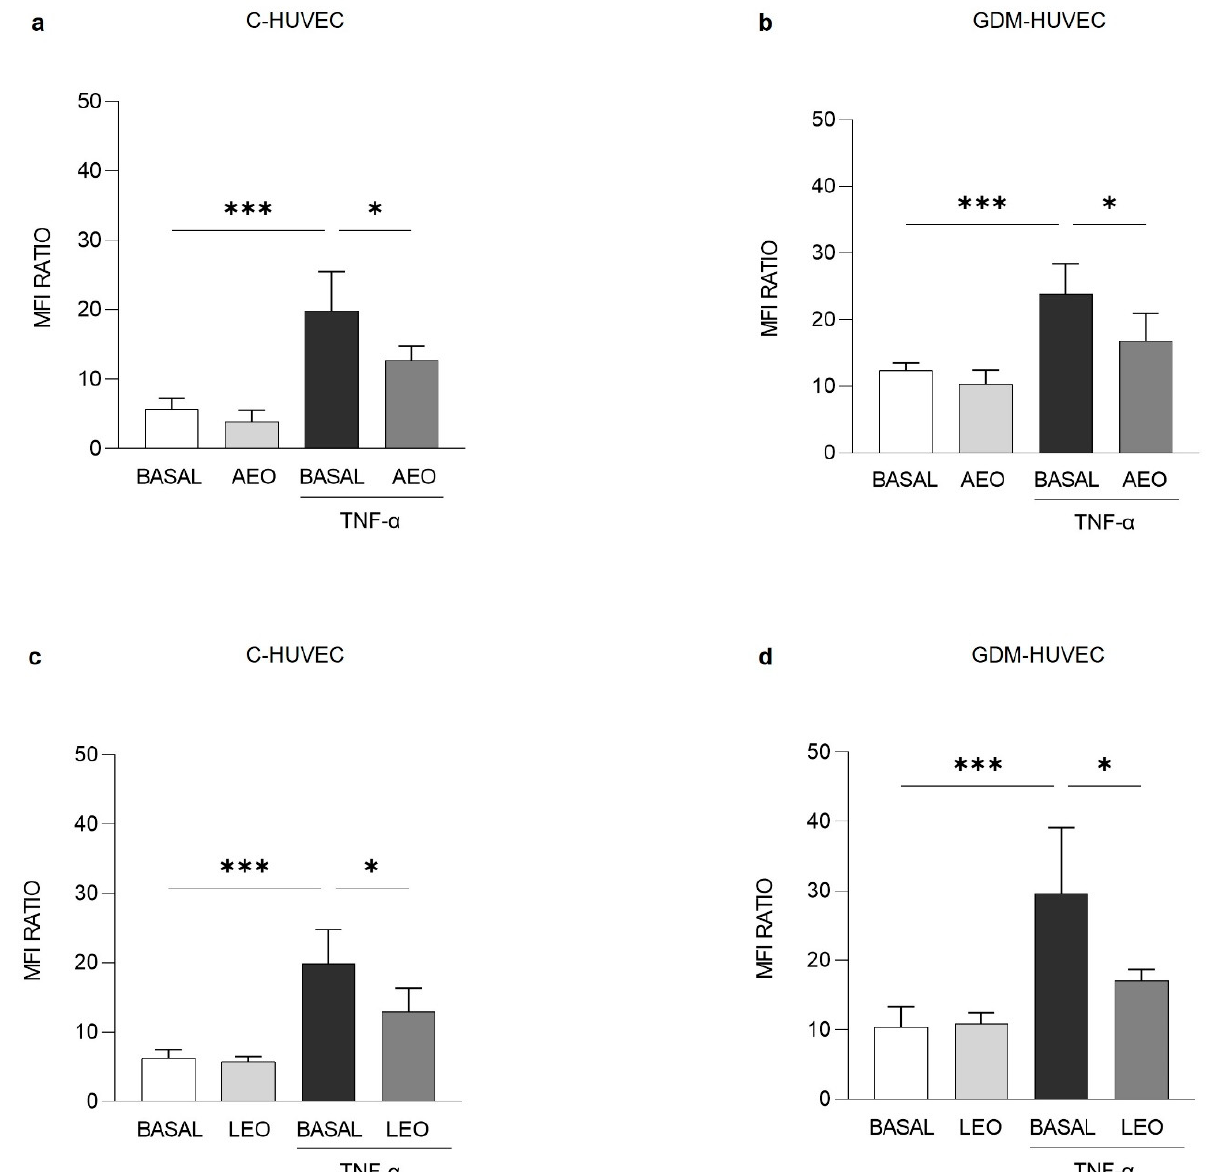
Figure 4. Effects of ( a , b ) AEO and ( c , d ) LEO on VCAM-1 membrane exposure levels in C- and GDM-HUVEC. Cells were serum-starved and incubated for 16h with TNF- α (1 ng/mL), following 24 h of pre-incubation with AEO or LEO (0.025% v / v ) or with medium alone (BASAL). Results are presented as Mean Fluorescence Intensity (MFI) Ratio and shown as mean ± Standard Deviation (SD). All experiments were conducted in technical and biological triplicate using at least 3 different primary culture strains of C- and GDM-HUVEC. ( a – d ) *** p < 0.001 TNF- α vs. BASAL; * p < 0.05 TNF- α vs AEO+TNF- α or LEO+TNF- α